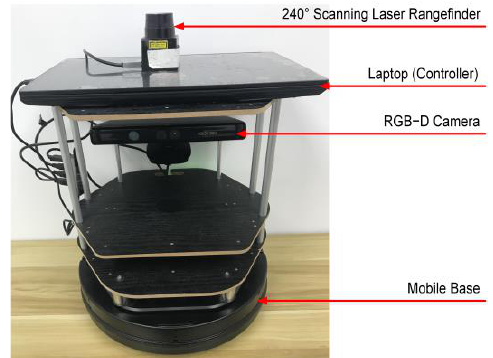
Figure 1. Mobile robot hardware configurations for autonomous navigation.